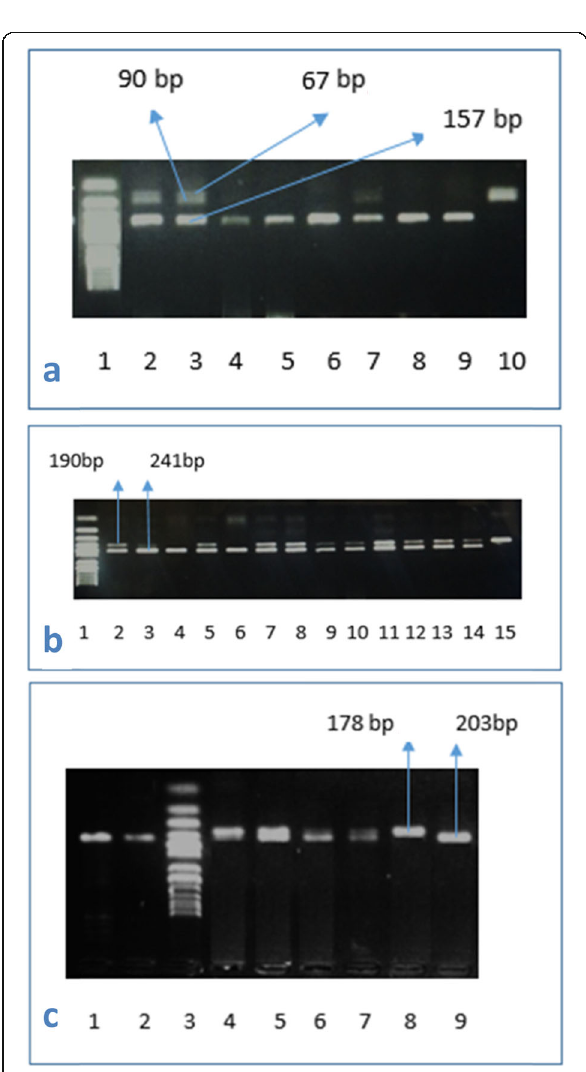
Fig. 1 A rs1927914 , PCR product size was 157 bp. Restriction